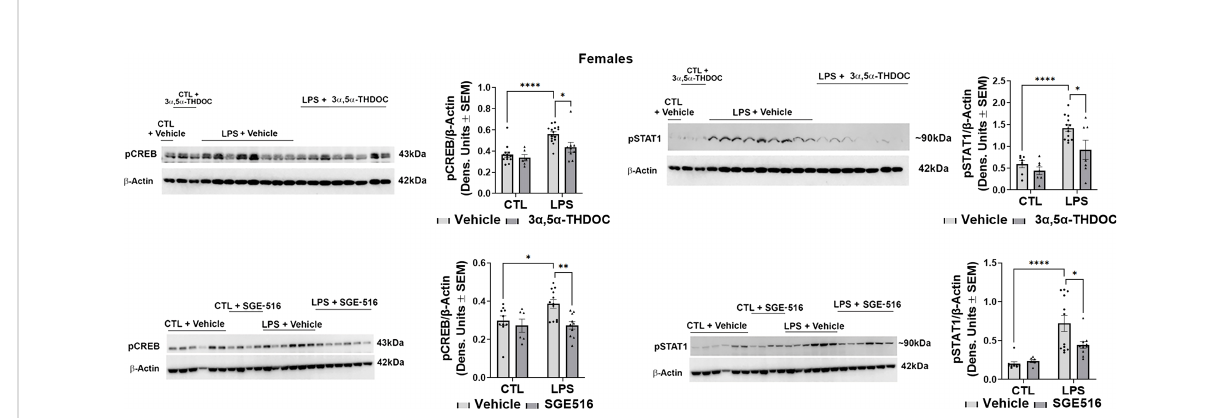
FIGURE 5 3 a ,5 a -THDOC and SGE-516 inhibit LPS-induced activation of MyD88-dependent TLR4 pro-in fl ammatory signal in human monocyte-derived macrophages (hMDM) from female donors. hMDM cultures were treated with LPS (1µg/ml; 24 h) with or without 3 a ,5 a -THDOC (1µM; 24 h) or SGE-516 (1µM; 24 h). Representative western blot images and summary data of densitometric scatter dot plots show the levels of pCREB and pSTAT1 in females. Each data point represents an individual hMDM culture (n ≥ 9 from 3 female donors/grp). b -Actin was used as protein loading control. LPS caused a signi fi cant increase in the levels of pCREB (~35%) and pSTAT1 (~60%) in hMDM from female donors relative to vehicle control (CTL). The increases of pCREB were completely inhibited by 3 a ,5 a -THDOC and SGE-516. The increases of pSTAT1 were completely inhibited by 3 a ,5 a -THDOC and partially inhibited by SGE-516 (~30%). Two-way ANOVA, Tukey ’ s post hoc test: *p<0.05, **p<0.01,